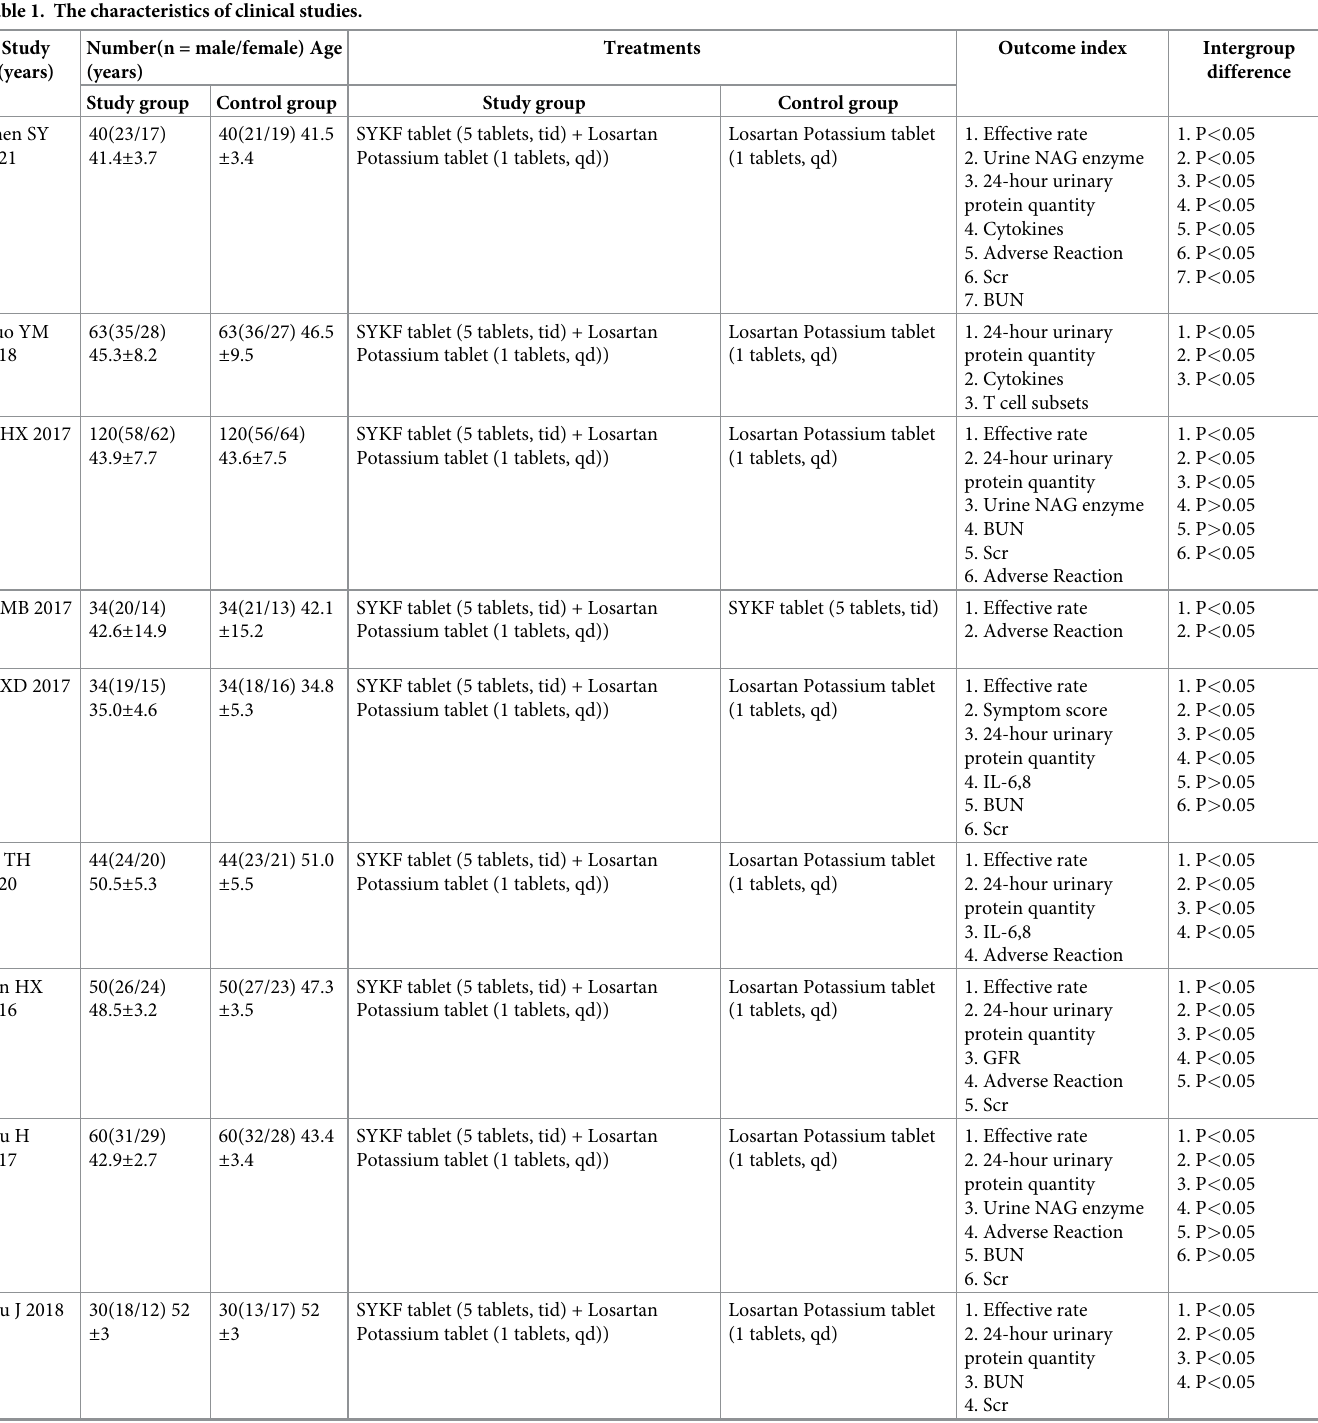
Table 1. The characteristics of clinical